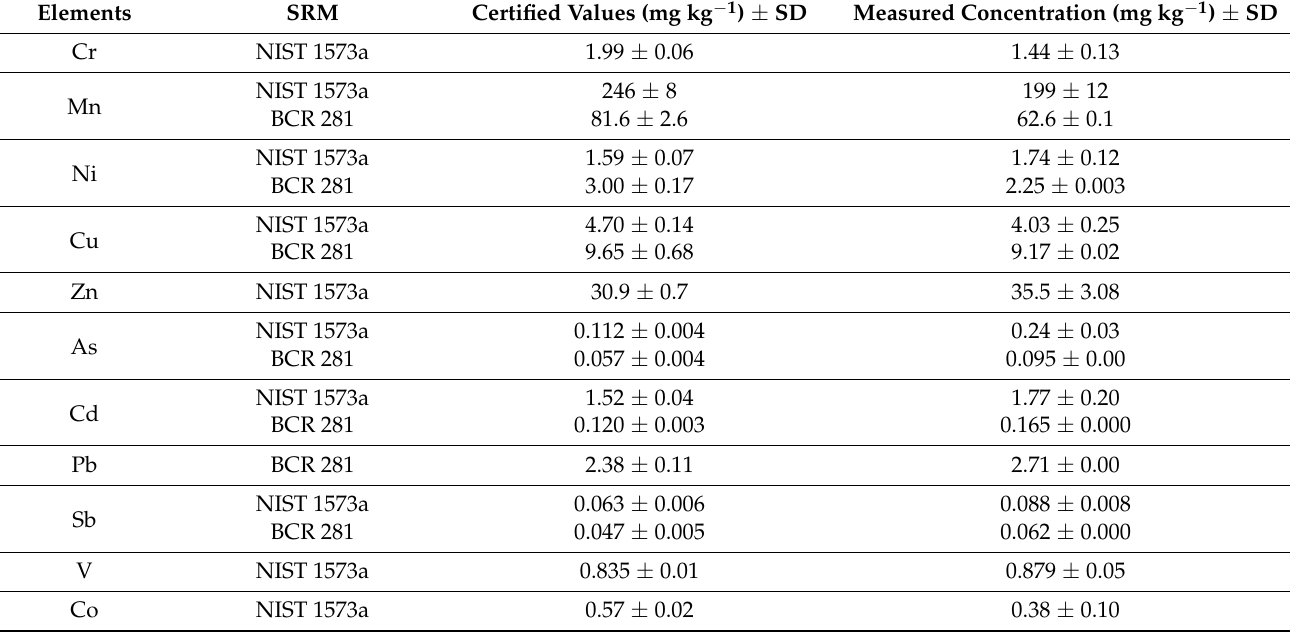
Table 1. Results summary for the standard reference materials National Institute of Standards and Technology (NIST) 1573a (tomato leaves) and Community Bureau of Reference (BCR) 281 (rye